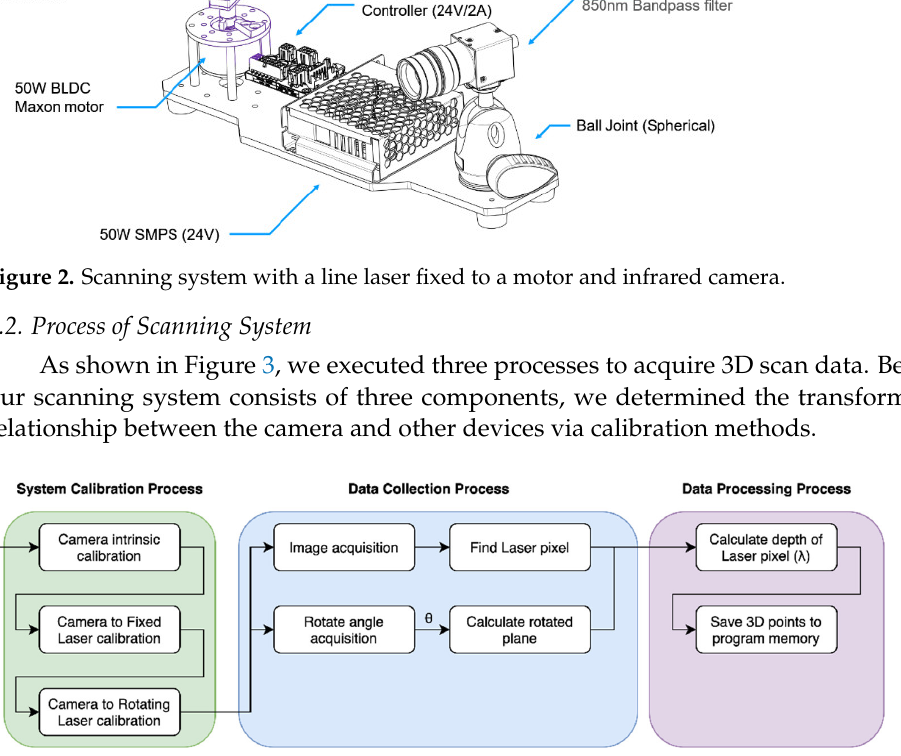
Figure 2. Scanning system with a line laser fixed to a motor and infrared camera.